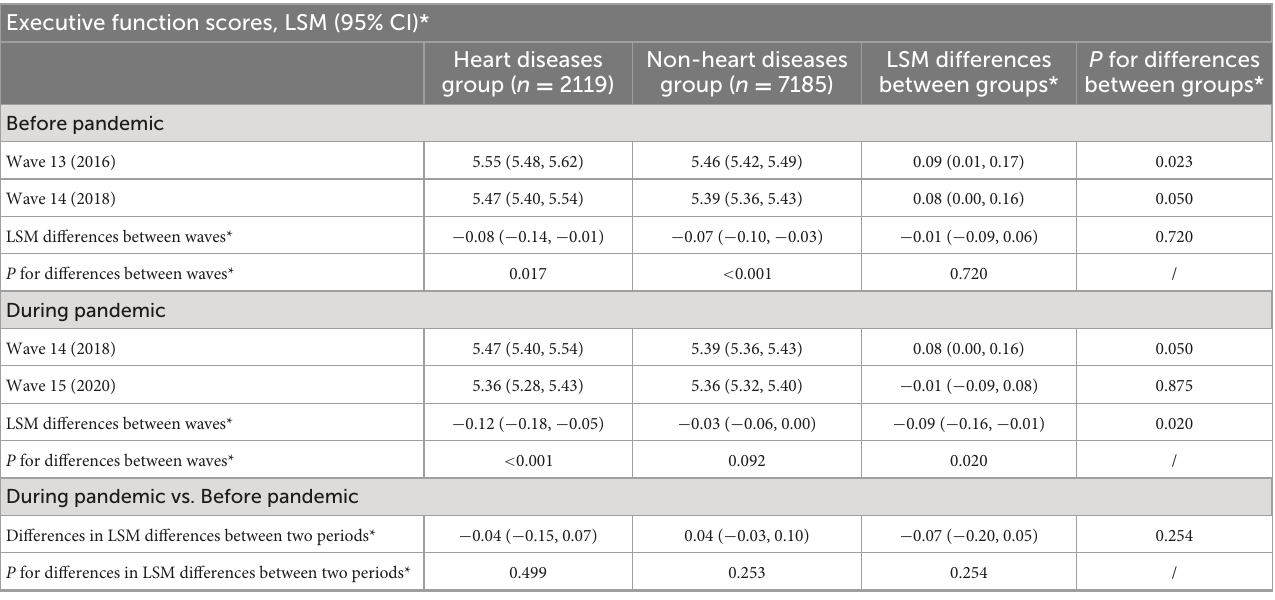
TABLE 4 Differences in the changes of executive function scores before and during the pandemic period, by heart disease status. Executive function scores, LSM (95% CI)*